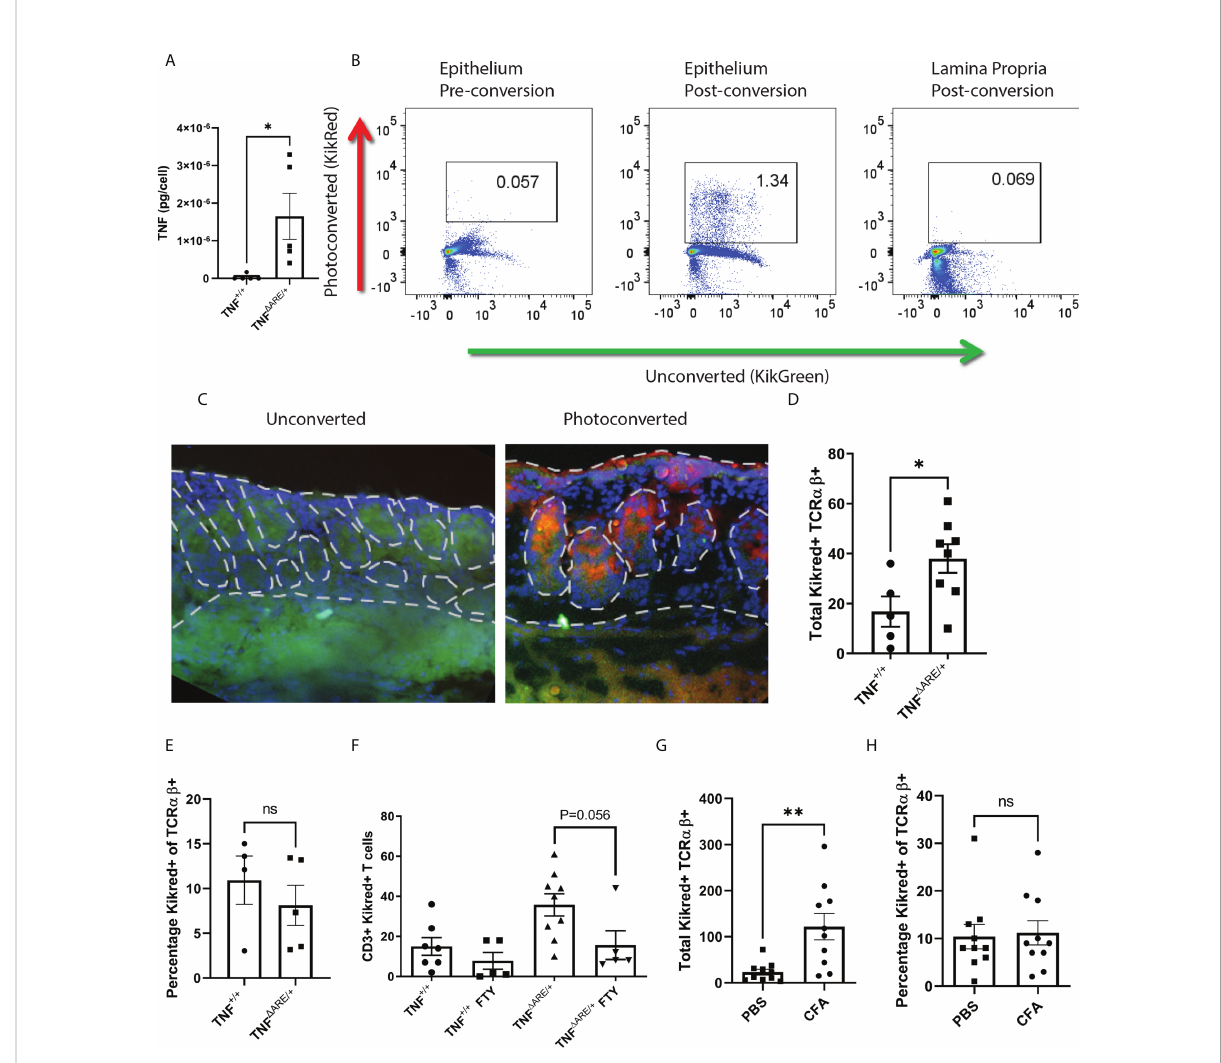
FIGURE 1 IELs engage in constitutive gut-joint traf fi cking. IELs were isolated from the colon epithelia of 8-10 week old male and female TNF D ARE/+ mice (n=5) and TNF +/+ littermate controls (N=5). (A) IELs were stimulated with PMA and Ionomycin overnight, the supernatant was assayed for TNF by ELISA and per cell TNF production calculated. Each symbol represents an individual mouse with bars as mean ± SEM. *P<0.05 by Student ’ s t-test. (B) KikGreen versus KikRed protein signal was compared by fl ow cytometry before and after photoconversion in the epithelium and lamina propria. (C) Representative immuno fl uorescence at 400X magni fi cation is shown of colon tissue harvested from a KikGR+ mouse that had just undergone photoconversion and from an unconverted control. (D, E) 72 hours post photo-conversion the Achilles enthesis was harvested from TNF D ARE/+ (n=8) and TNF +/+ littermate controls (n=5) and assayed for the presence of photoconverted KikRed+ CD3+ TCR ab + T cells by fl ow cytometry. (D) Absolute number and (E) percentage is shown for each mouse (symbols) with mean ± SEM (bars). (F) 8-10 week old male and female KikGR+ mice received a photoconversion of the distal colon and daily i.p. injections of 1mg/kg FTY720 or 10% DMSO vehicle control. Absolute number of KikRed+ CD3+ TCR ab + T cells were measured by fl ow cytometry. (G, H) KikGR + mice (n=10) received an injection of 20mg CFA in the hind hock and a injection of PBS in the contralateral hock simultaneously to having undergone photoconversion of the distal colon. 72 hours post injection, each Achilles enthesis was harvested and (G) total and (H) percentage of KikRed+ CD3+ TCR ab + T cells were enumerated by fl ow cytometry. Data are shown as individual mice across three separate experiments with bars as mean ± SEM. *P<0.05; **P<0.01 , and ns, non-signi fi cant as determined by Student ’ s t-test, and paired Student ’ s T test for (G, H)